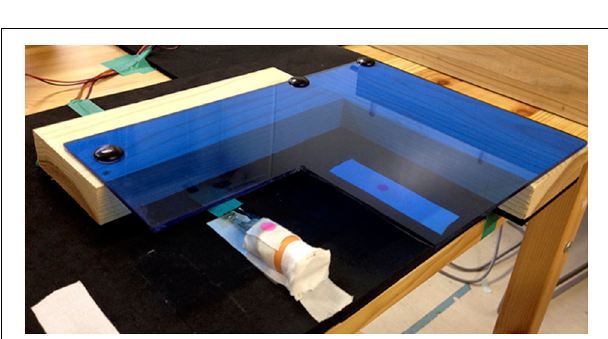
touch the upper surface of the table (Uncrossed × Active) or the back of the left hand (Crossed × Active). In ROS condition, an acrylic stand (30mm in height) was placed on the right side of the rubber finger so that the palm of the right hand can rest on surface. The stand can separate the palm of the right hand from the back of the left hand at a short distance in Crossed × ROS.